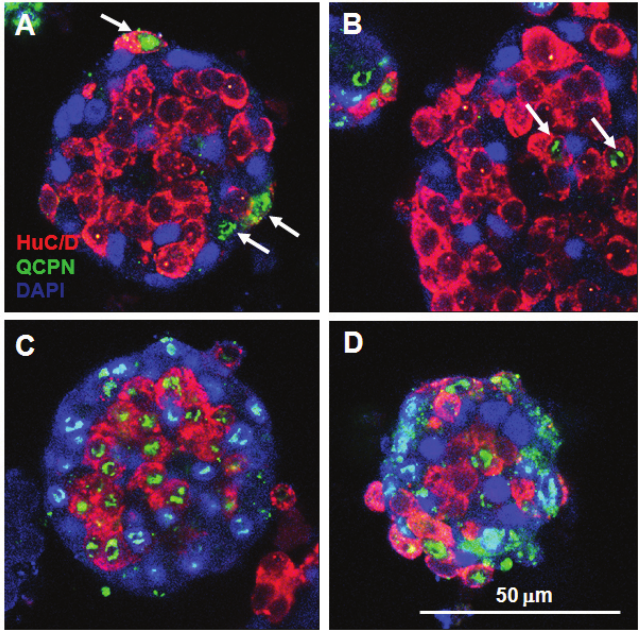
Figure 7. Cells in ENS aggregates are mobile and the surface of formed ENS cell aggregates is relatively non-adhesive. A . Few freshly dissociated E8 quail ENS cells (arrows, labelled QCPN +ve in green) at 3 h in vitro attached to the periphery of pre-formed (21 h) E9 chick ENS QCPN -ve cell aggregates. B . At 18 h in vitro some quail ENS cells (arrows) relocated deep into the chick ENS 36 h aggregate. C . Most quail ENS cells formed entirely quail cell aggregates after 18 h, rather than adhering to pre-formed chick ENS cell aggregates. D . QE8 and ChE9 ENS cells when combined as freshly dissociated cells formed mixed aggregates at 6 h, showing that there is no species-related adhesive incompatibility. All specimens were labelled with HuC/D, QCPN and SoxE. Scale bar applies to all